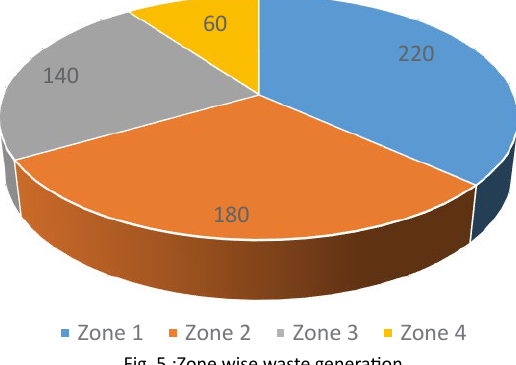
Fig. 5.:Zone wise waste